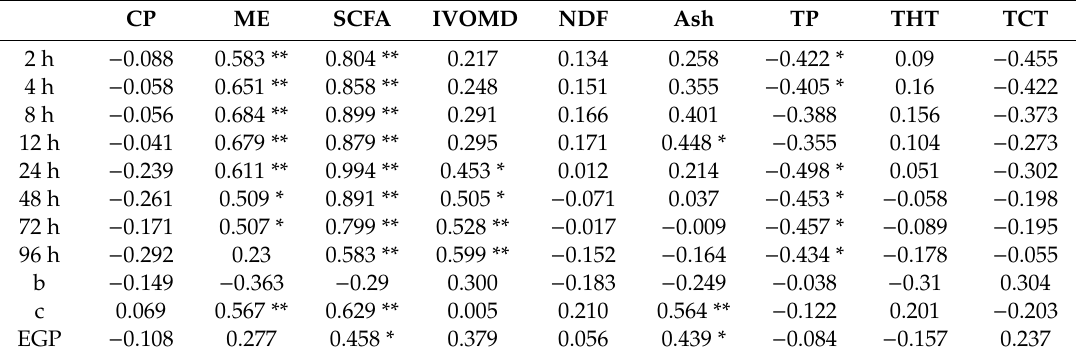
Table 8. Pearson correlation coe ffi cients among chemical analysis, phenolic compounds and gas